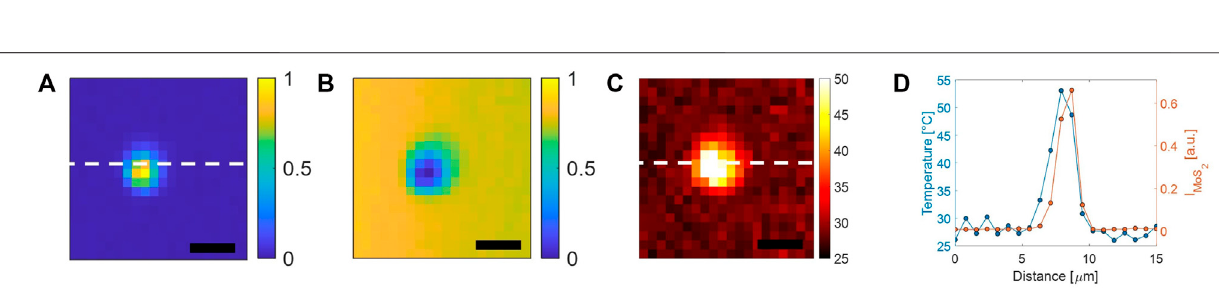
and T values obtained along the white 2